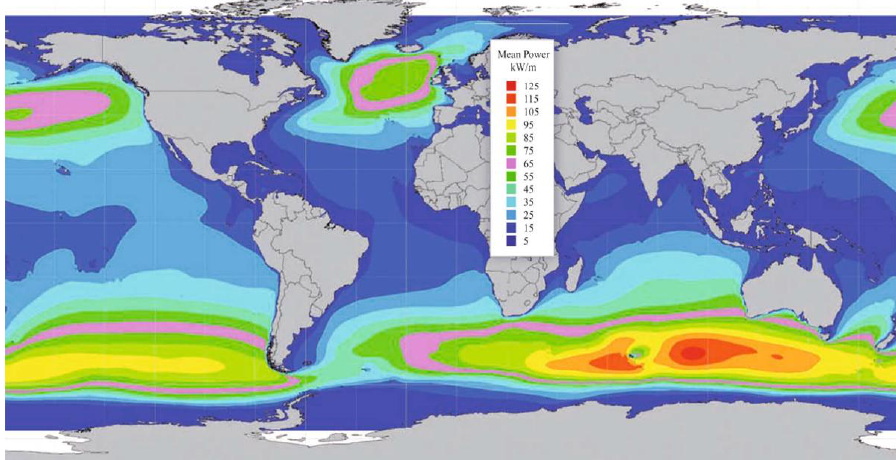
Figure 4. Global distribution of mean power in kW/m of ocean wave generated by the WAVEWATCH-III wind wave model using wave climate data between 1997 and 2006 [62].